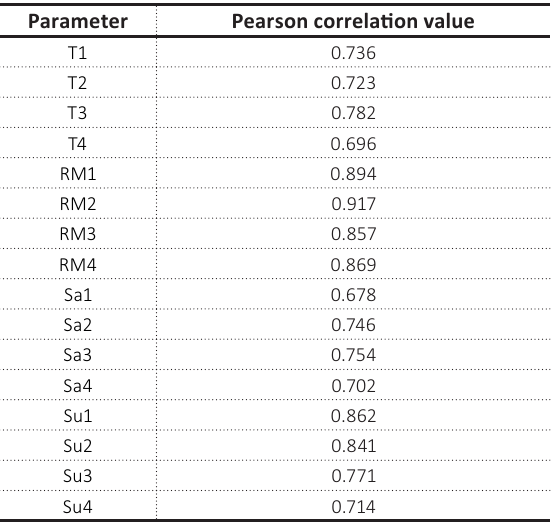
Table 1. Validity test results